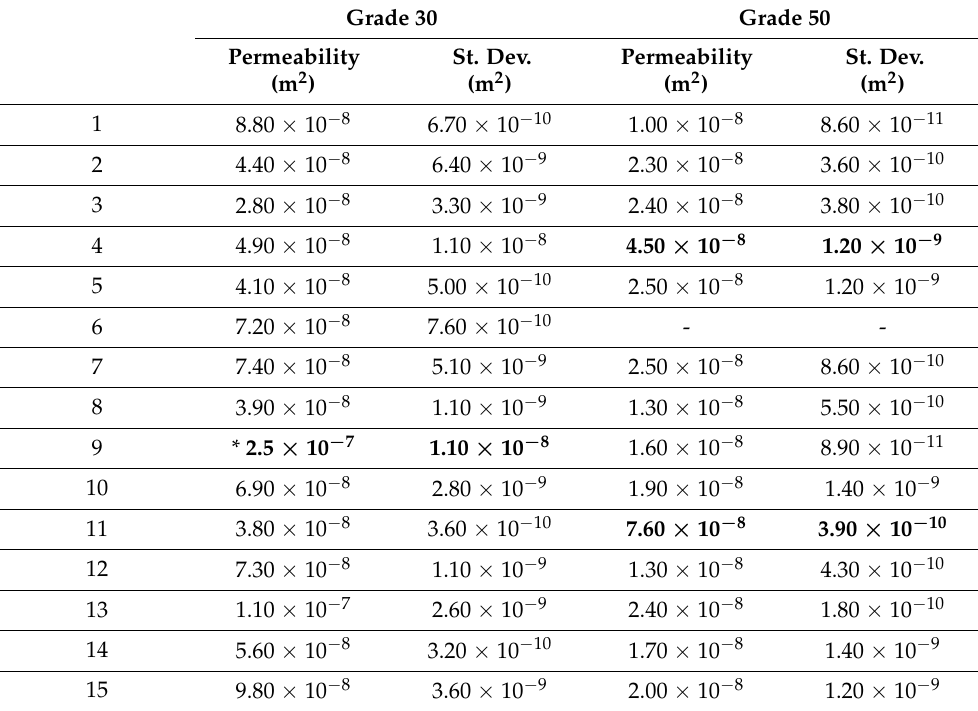
Table A13. Permeability of CFF samples of Grade 30 and Grade 50 from supplier